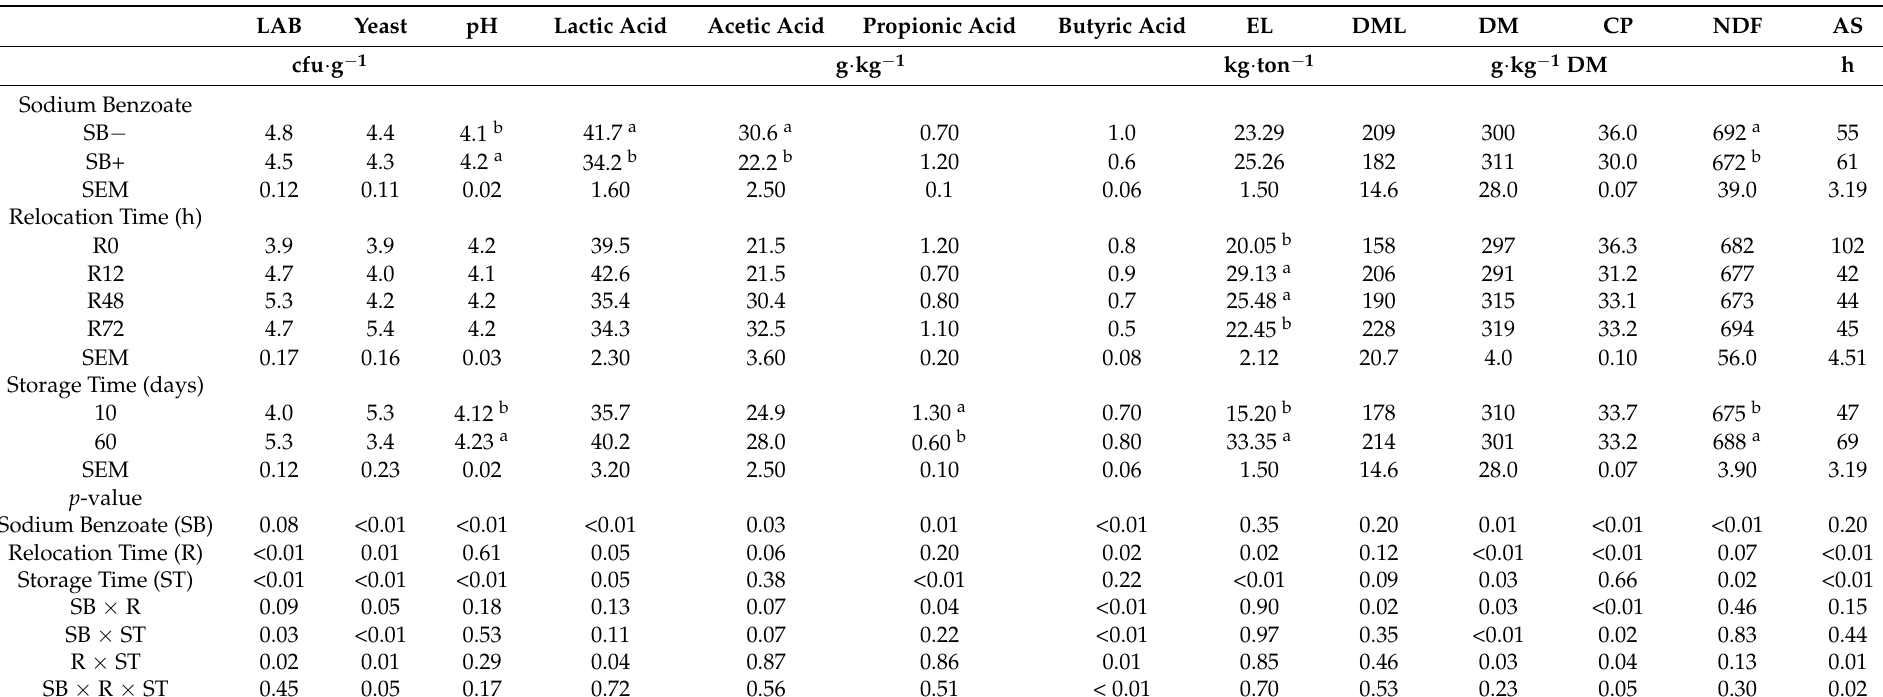
Table 2. The effects of sodium benzoate application (at 2 g · kg − 1 on a fresh matter basis), relocation time, storage time, and their interactions on the chemical composition, fermentative losses, microbiology, and aerobic stability of sugarcane